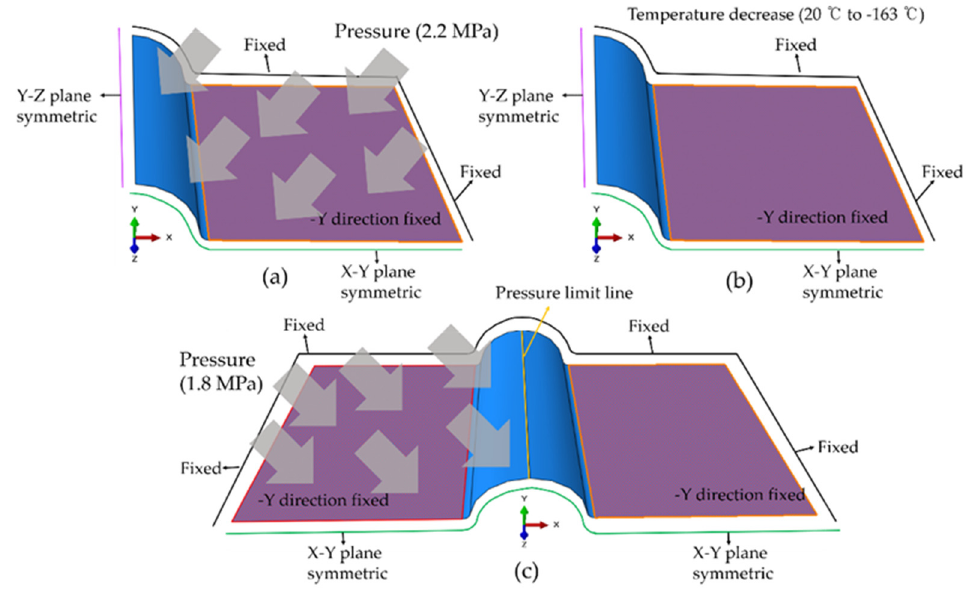
Figure 4. Loading and boundary conditions in ( a ) symmetric hydrodynamic pressure, ( b ) thermal shrinkage, and ( c ) asymmetric hydrodynamic pressure analysis. The red rectangles represent the flat bottom of the SPB, and each line represents a side of the SPB. Furthermore, the gray arrows indicating the pressure direction do not cross the yellow pressure limit line.